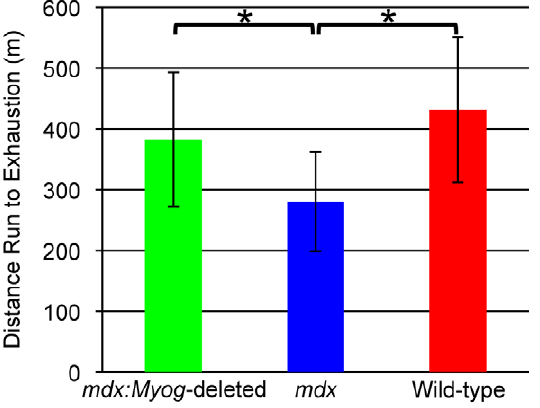
Figure 2. Enhanced exercise endurance capacity in mdx:Myog - deleted mice during the high-intensity exercise regimen. mdx:Myog -deleted mice (n=14) over the course of 3 consecutive days of running ran 37% more than mdx mice (n=14) and 11% less than wild-type mice (n=14) under high-intensity exercise conditions. Error bars represent 1 standard deviation (* p , 0.05).